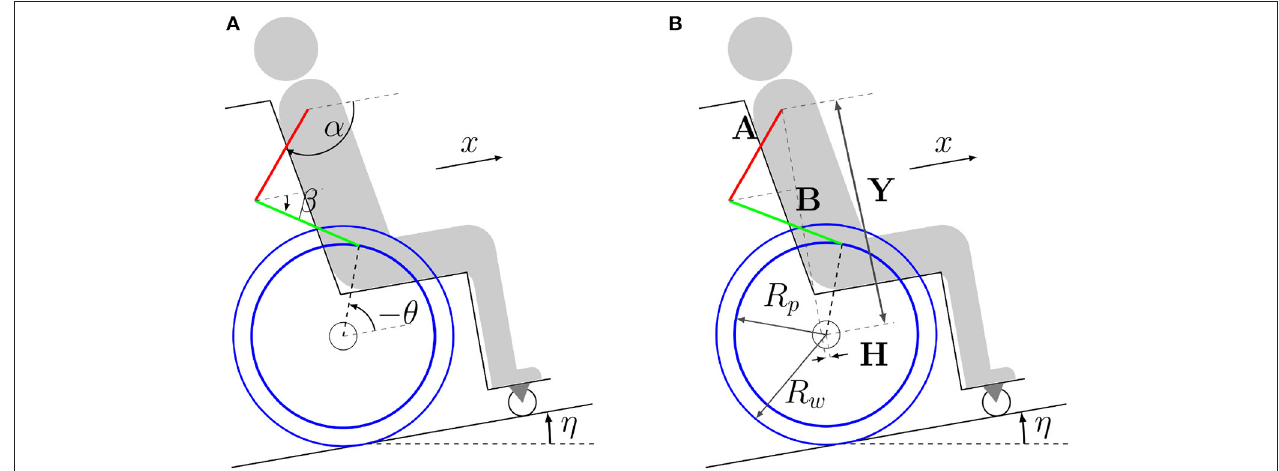
FIGURE 1 | Model of the wheelchair-user system composed of four rigid bodies representing arms (red), forearms (green), rear wheels (blue) and the remaining body and wheelchair elements (gray/black). Coordinates are represented in figure (A) , where α is the upper arm angle with respect to the direction of motion, β is the forearm angle with respect to the direction of motion, θ is the rear wheel angular displacement, x is the forward displacement of the shoulder/wheelchair and η is the ramp inclination angle. Lengths are represented in figure (B) , where Y is the relative vertical and H is the relative horizontal distance between the center of the rear wheels and the shoulder, A is the upper arm length, B is the forearm length, R p is the pushrim radius, and R w is the rear wheel radius.